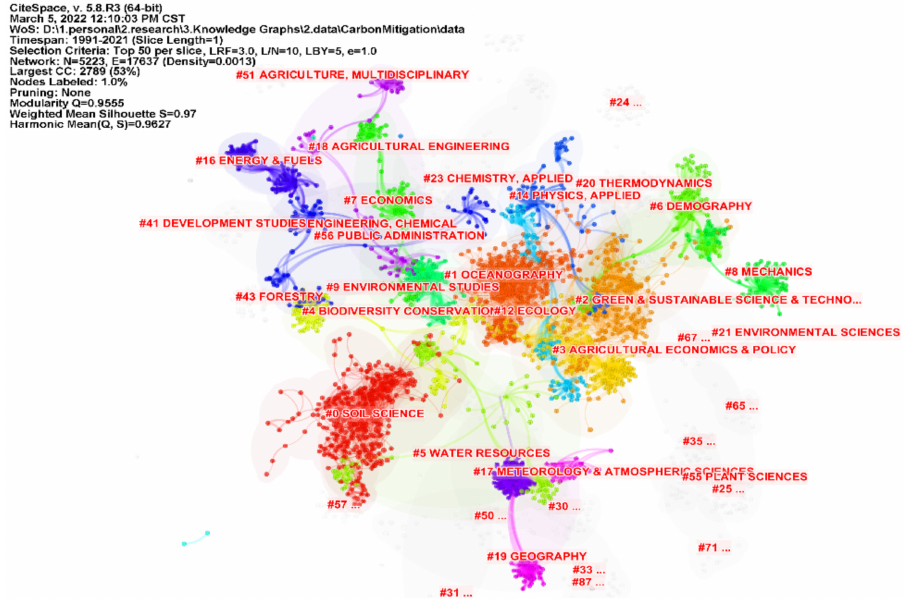
Figure 7. Knowledge Map of Cited Literature on Carbon Emission Reduction Research Based on Discipline